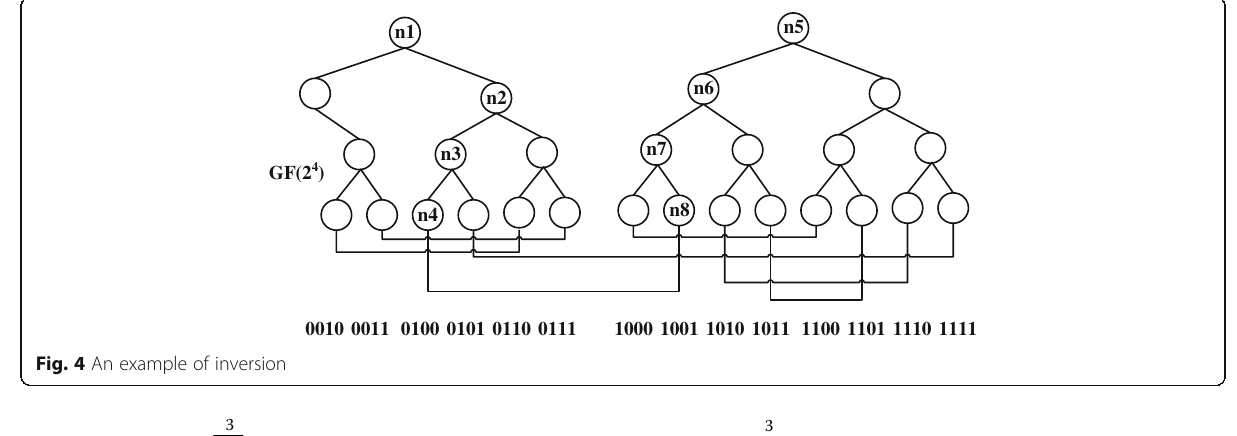
Fig. 4 An example of